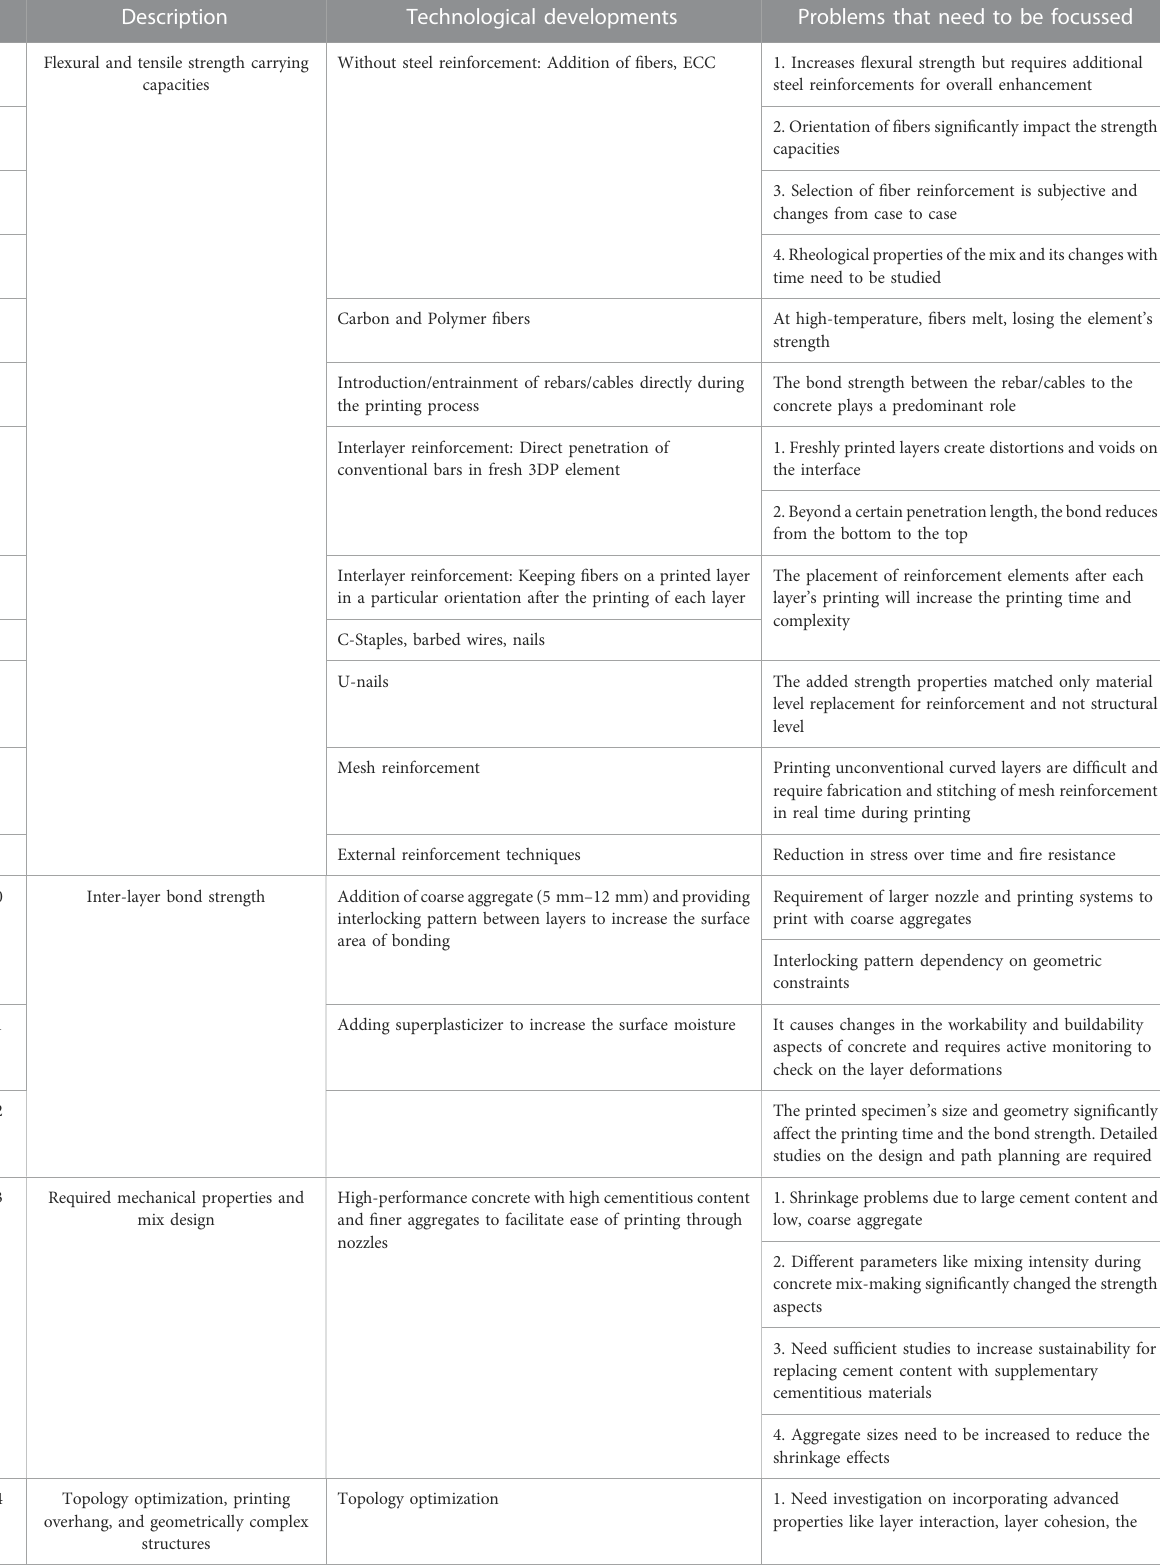
TABLE 2 Major problems that need to be addressed for 3D-printed structural